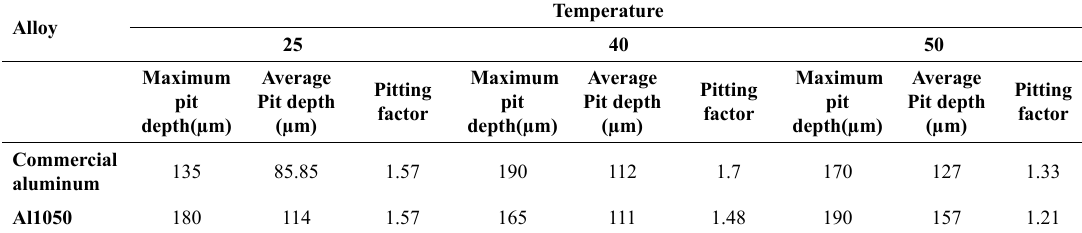
Table 6. Depth of pits for alloys at different temperatures after 16 days of immersion in S J ethanol.